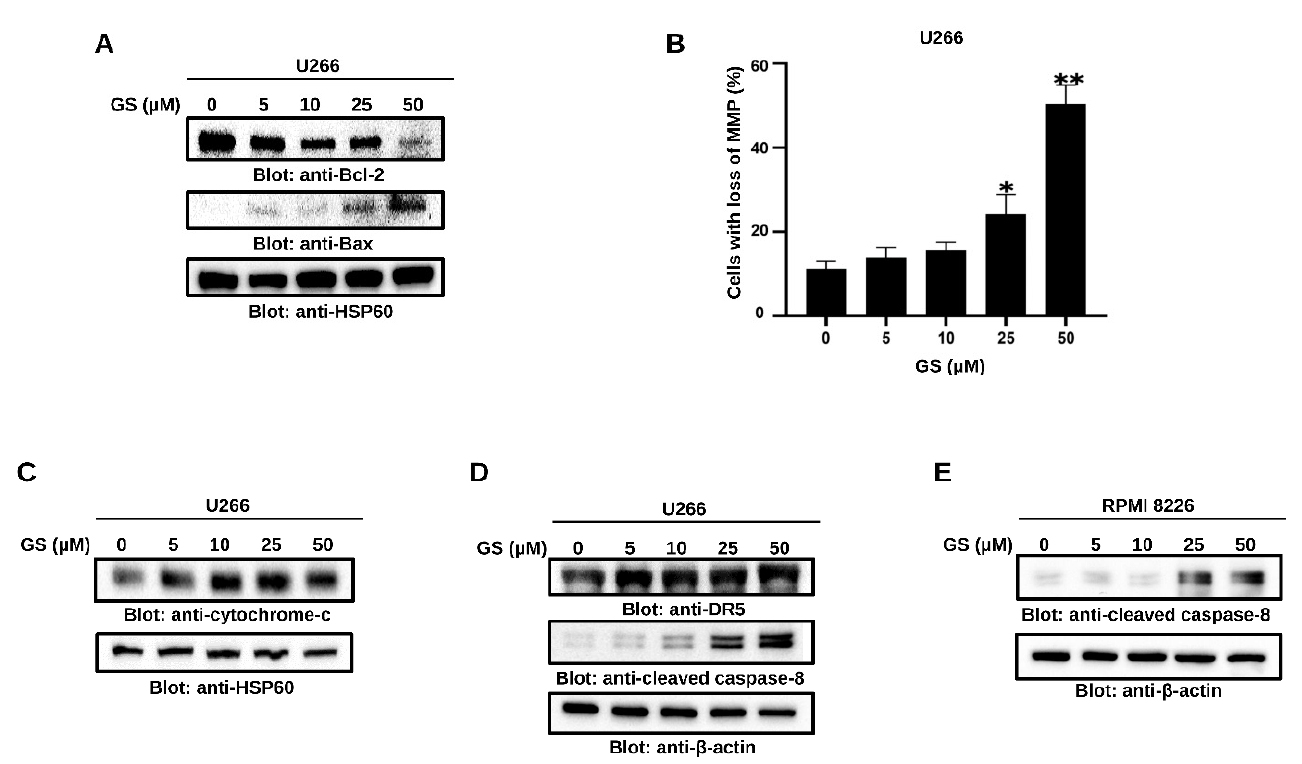
Figure 3. GS-mediated intrinsic and extrinsic apoptotic pathways in MM cells. U266 cells were treated with increasing concentrations of GS for 48 h, and cell lysates were immunoblotted with antibodies for ( A ) Bcl-2, Bax, and HSP60. ( B ) U266 cells were incubated with 5, 10, 25, and 50 µ M of GS for 48 h, and cells were stained with JC1 stain and analyzed using flow cytometry. The graph displays the mean ± SD of three different experiments * p < 0.05 ** p < 0.01. U266 and RPMI 8226 cells were treated with increasing concentrations of GS for 48 h, and protein expression levels of ( C ) cytochrome c, HSP60. ( D ) DR-5, cleaved caspase-8, and β -actin in U266 cells and ( E ) cleaved caspase-8, and β -actin in RPMI 8226 cells were determined. Full Western blot images can be found at Supplementary Materials File S1.